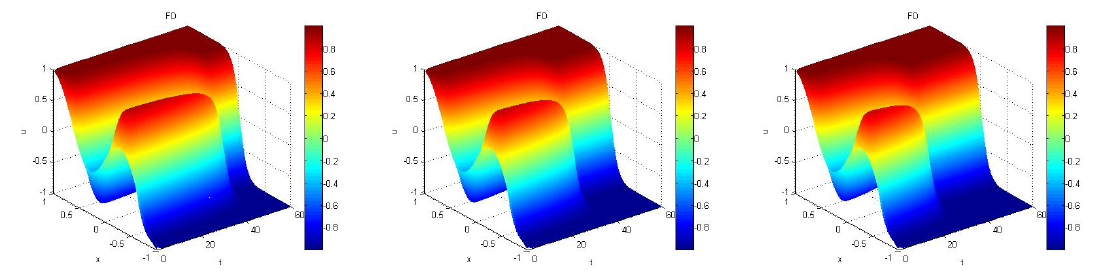
Figure 8. [Test 3] Solution of the full discretized systems with (cid:101) = 0.0095,0.01,0.0105 (from left to right).